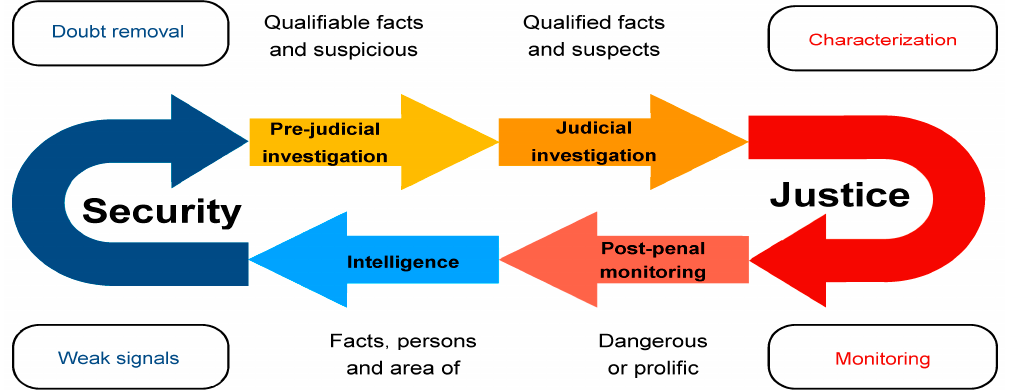
Figure 2. Continuity of information processing between security action and justice action (adapted from Barlatier 2017, p. 287).